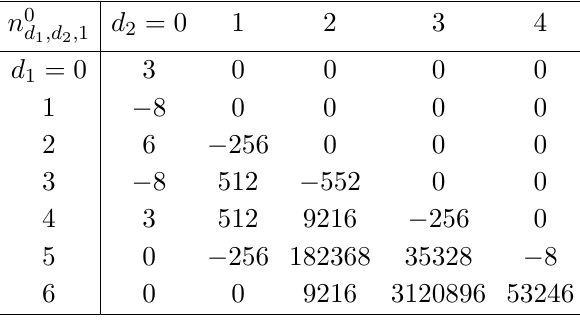
Table 3 . Low degree genus zero Gopakumar-Vafa invariants at base degree one for the elliptically fibered Calabi-Yau threefold with 2 sections that arises from the toric data